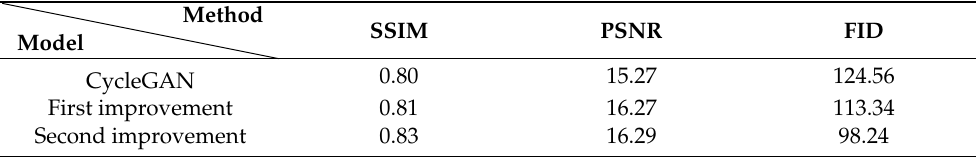
Table 5. Quantitative results of profile face